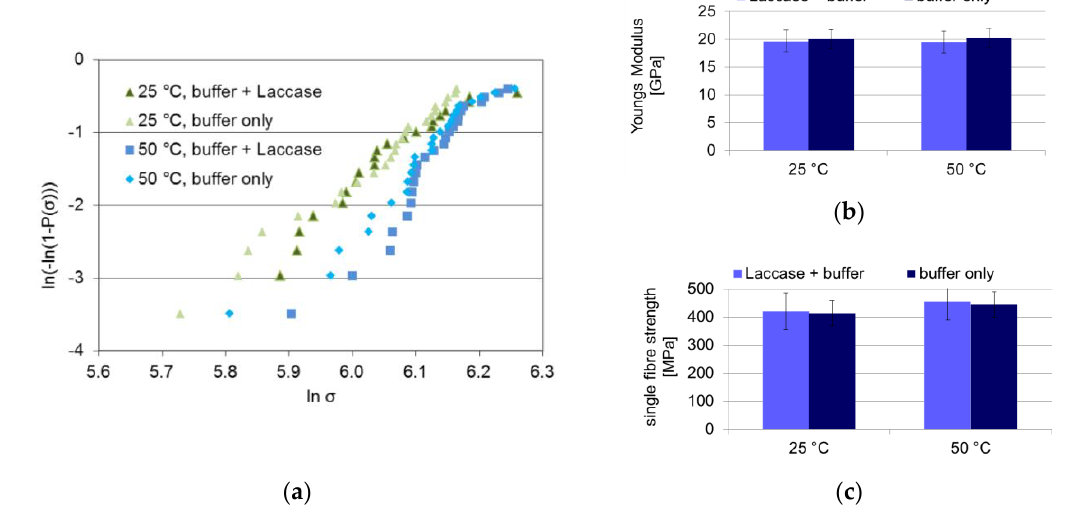
Figure 1. Results of single fibre tensile tests of buffer- and laccase-treated fibres and buffer-only fibres (“control”) for 25 and 50 °C: ( a ) Weibull plot, ( b ) Young’s modulus, ( c ) tensile strength. In ( b , c ), the mean and an error of one standard deviation is shown.